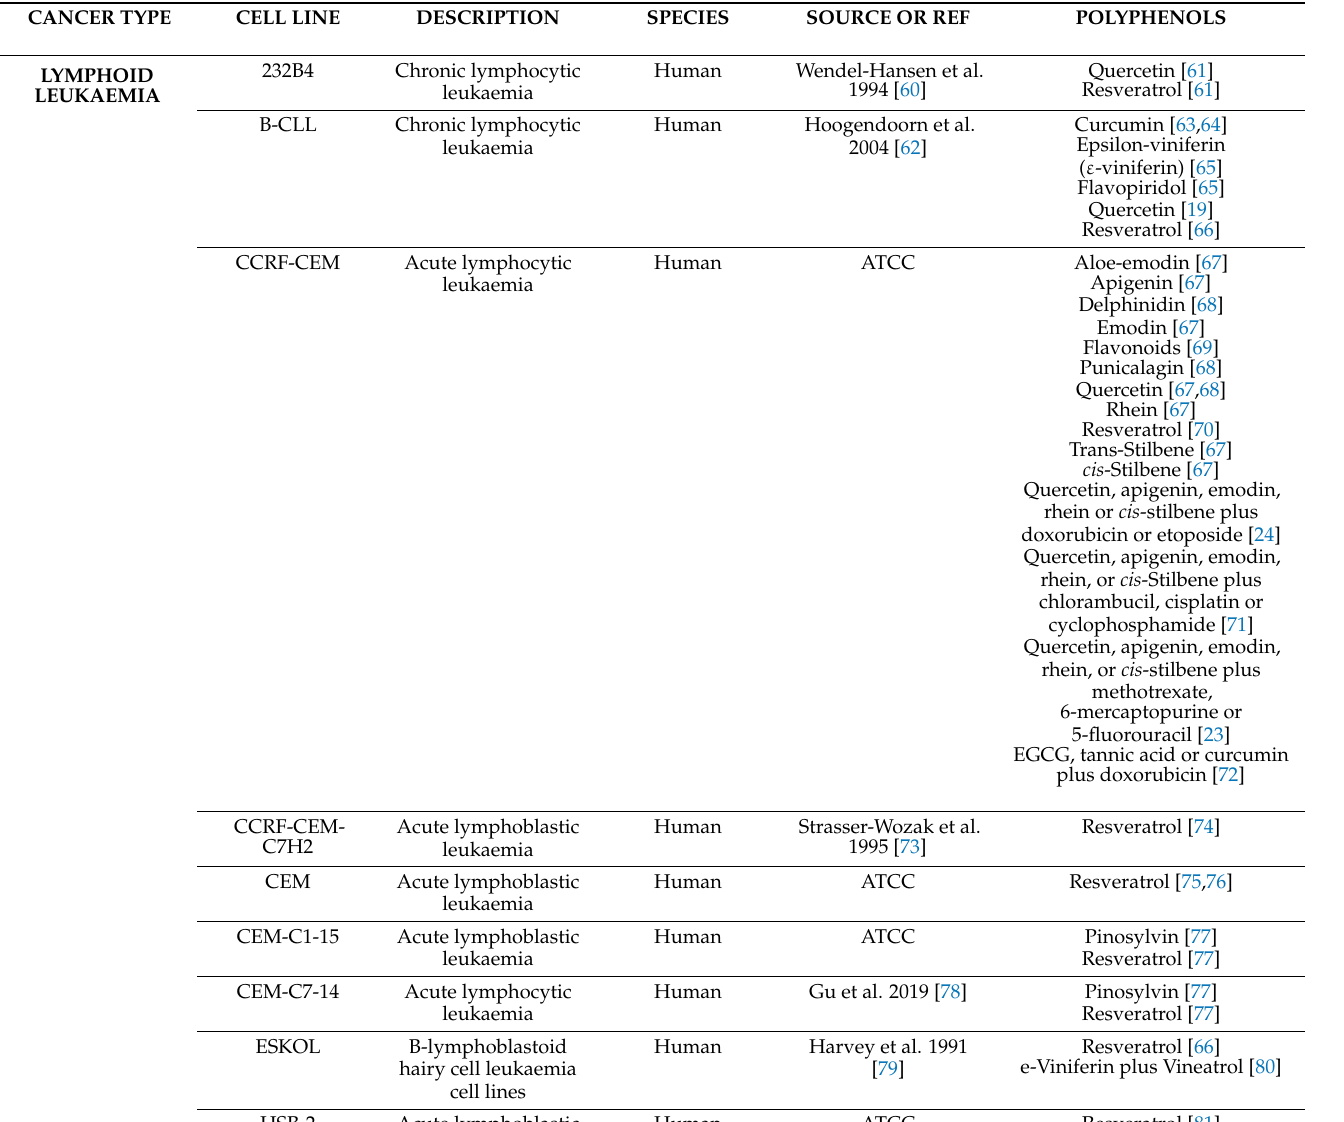
Table 1. Summary of leukaemia cells lines discussed within this review, including the species of origin, designated abbreviation, commercial source or reference where the cell line was introduced and specific polyphenols that affect the cell